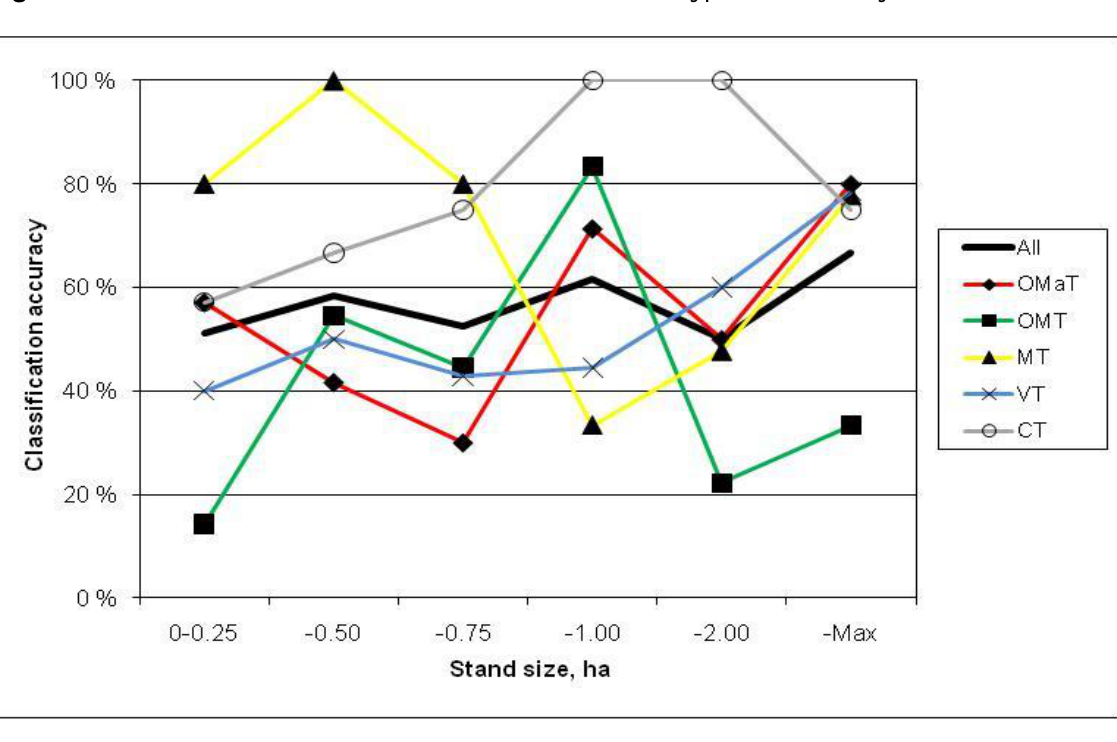
Figure 3. Classification accuracies of different forest site types obtained by stand size